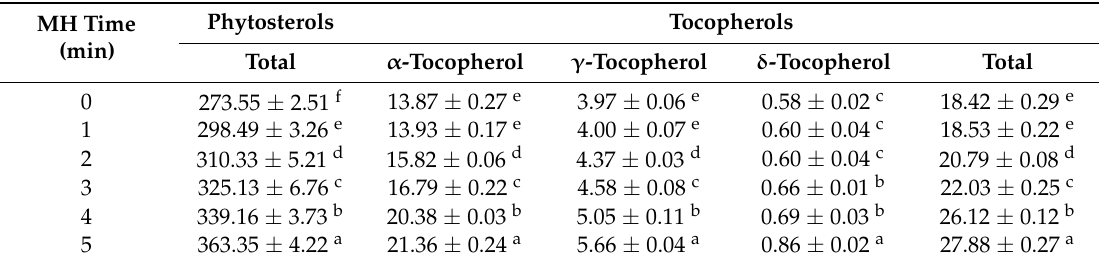
Table 2. Effect of microwave pretreatment on free phytosterols and tocopherols content (mg/100 g) in